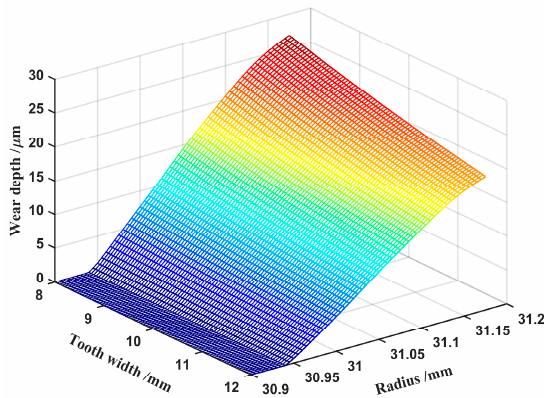
Figure 19. Effect of tooth width on wear depth.